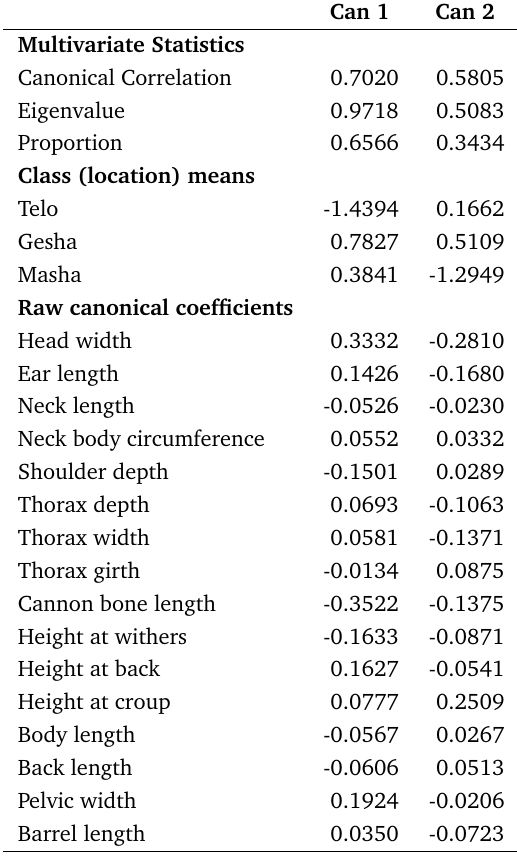
Table 11. Canonical correlations, eigenvalues, and class means.